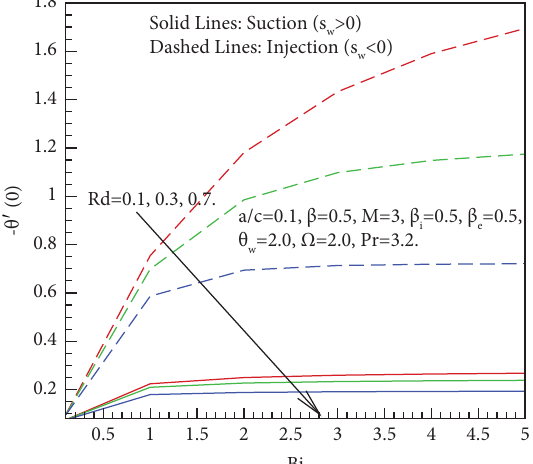
e against ion slip parameter β i